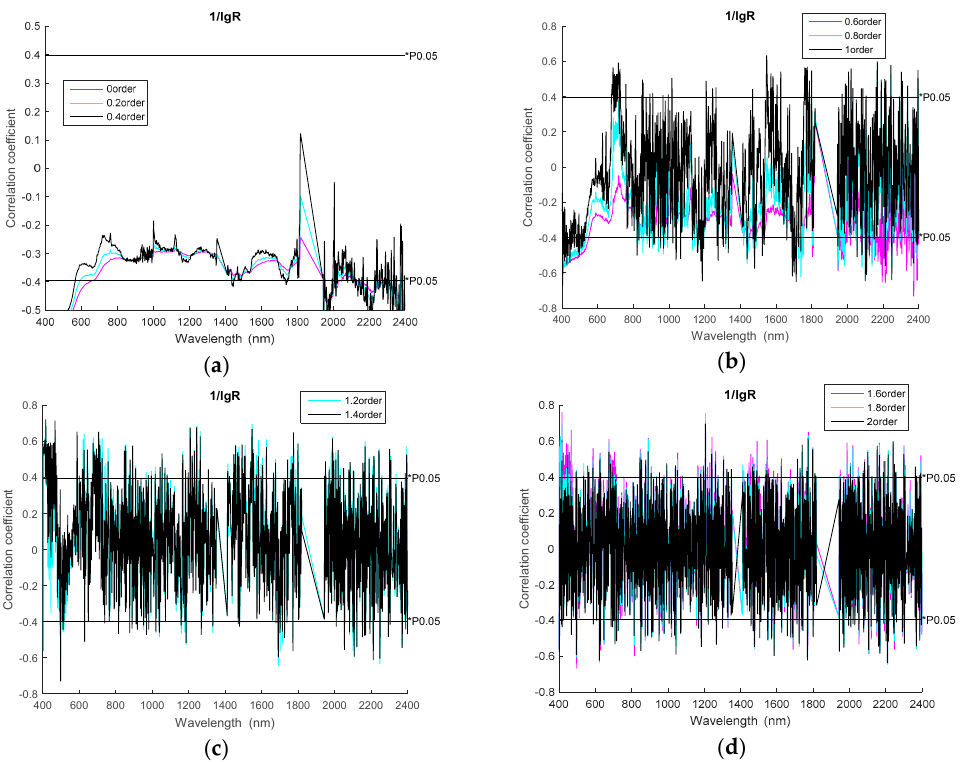
Figure 5. Trends of correlation coe ffi cient for logarithm reciprocal: ( a ) 0-order to 0.4-order; ( b ) 0.6-order to 1-order; ( c ) 1.2-order to 1.4-order; and ( d ) 1.6-order to